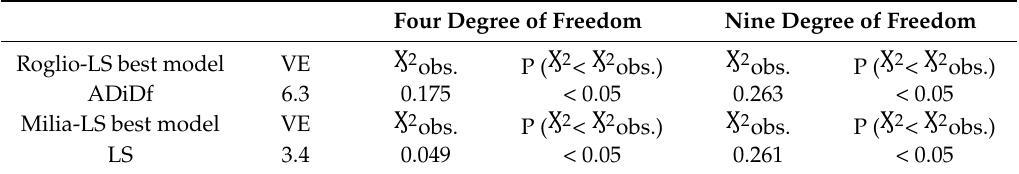
Table 3. Chi-square statistics of the best models. The chi-square tests were performed with 4 degree of freedom and 0.05 confidence level (